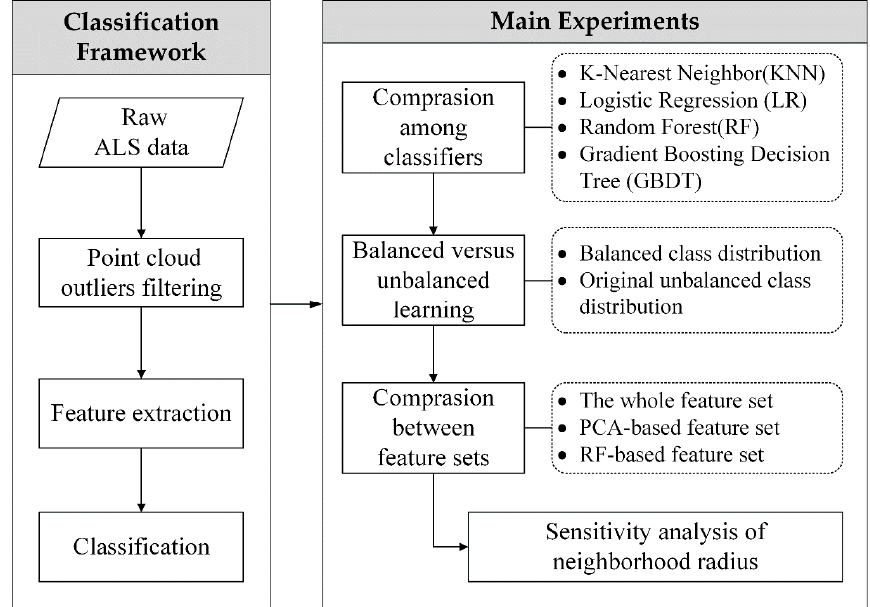
Figure 4. The complete flowchart of our study. This flowchart has been divided into two parts. The left box is the basic classification framework and the right box lists the main experiments, including comparison among classifiers, balanced versus unbalanced learning, comparison between feature sets, and sensitivity analysis of neighborhood radius. All classifiers, feature sets and class distribution tested are listed in the dotted box.